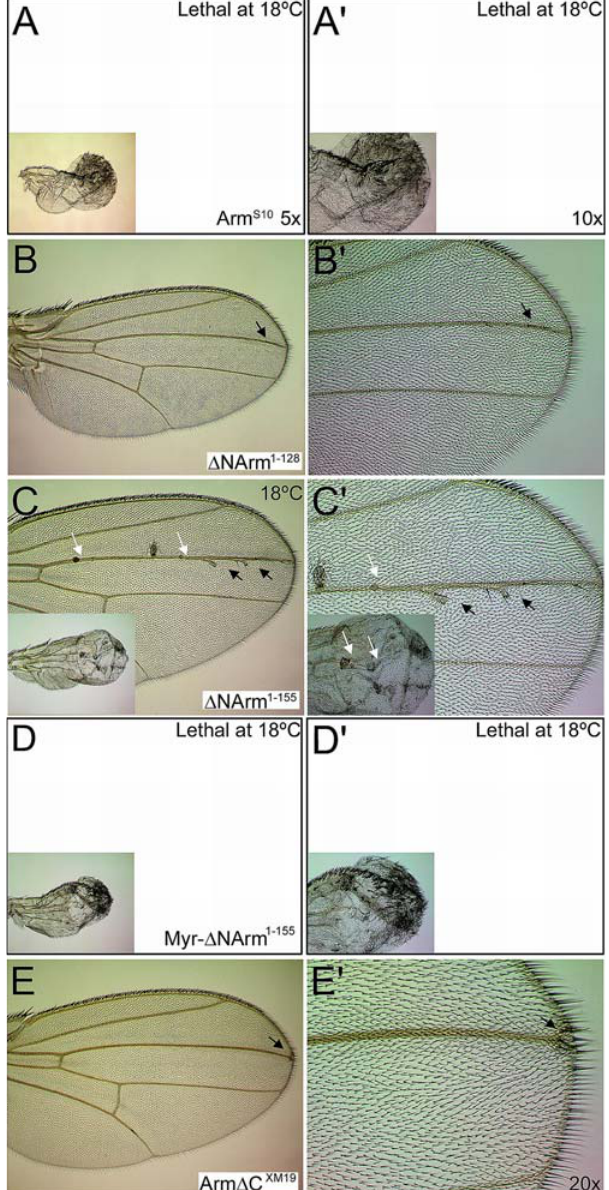
Figure 13. Armadillo mutants overexpressed with dppGAL4 induce ectopic bristles and veins in adult wings, with varying degrees of severity. (A, A 9 ) Arm S10 is lethal even at 18 u C using dppGAL4 , but results in a lawn of ectopic bristles using C5GAL4 (insets). (B, B 9 ) Only a very weak phenotype is caused by overexpression of D NArm 1–128 , inducing ectopic bristles on vein L3 near the wing margin (arrowheads). (C, C 9 ) Although ectopic bristles and veins are induced at 18 u C (arrowheads), the phenotype caused by D NArm 1–155 is predom- inantly neurogenic, with many ectopic sensillae along the wing veins (white arrows and inset, C5GAL4 ). (D, D 9 ) In contrast, even at 18 u C no pupae eclose when the tethered form is overexpressed with dppGAL4 . The phenotype induced by Myr- D NArm 1–155 is similar to, though more severe than, that of Arm S10 , causing a lawn of ectopic bristles to form with C5GAL4 (inset). (E, E 9 ) Arm D C XM19 has a very weak phenotype, with only few ectopic bristles forming at the wing margin at the tip of vein L3 (arrowheads).